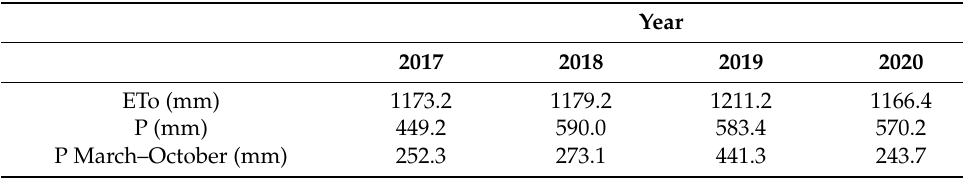
Table 1. Reference evapotranspiration, ETo; yearly precipitation, P; and cropping season, P March–